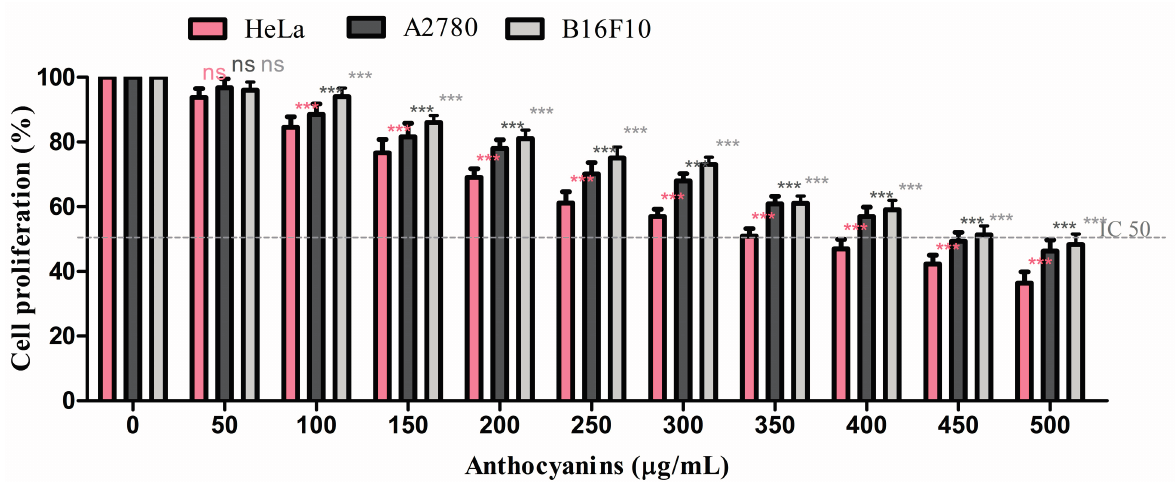
Figure 3. The antiproliferative effect of blueberry ARF on cancer cell lines. Statistical analysis was done using Dunnett multiple comparison test of Graph Pad Prism version 5.00. Data represent the means ± SD of at least three independent experiments (ns, none significant, *** extremely significant p < 0.001).